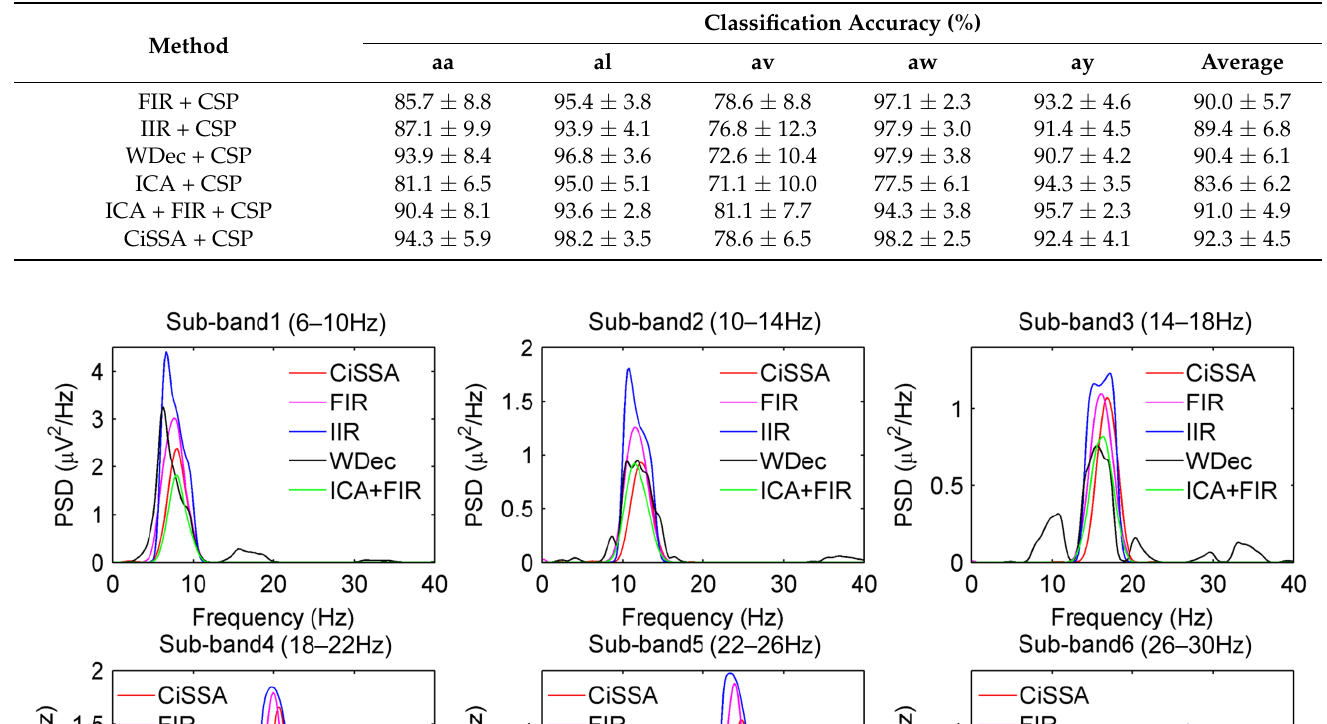
Table 2. The classification accuracies of FIR + CSP, IIR + CSP, WDec + CSP, ICA + CSP, ICA + FIR +